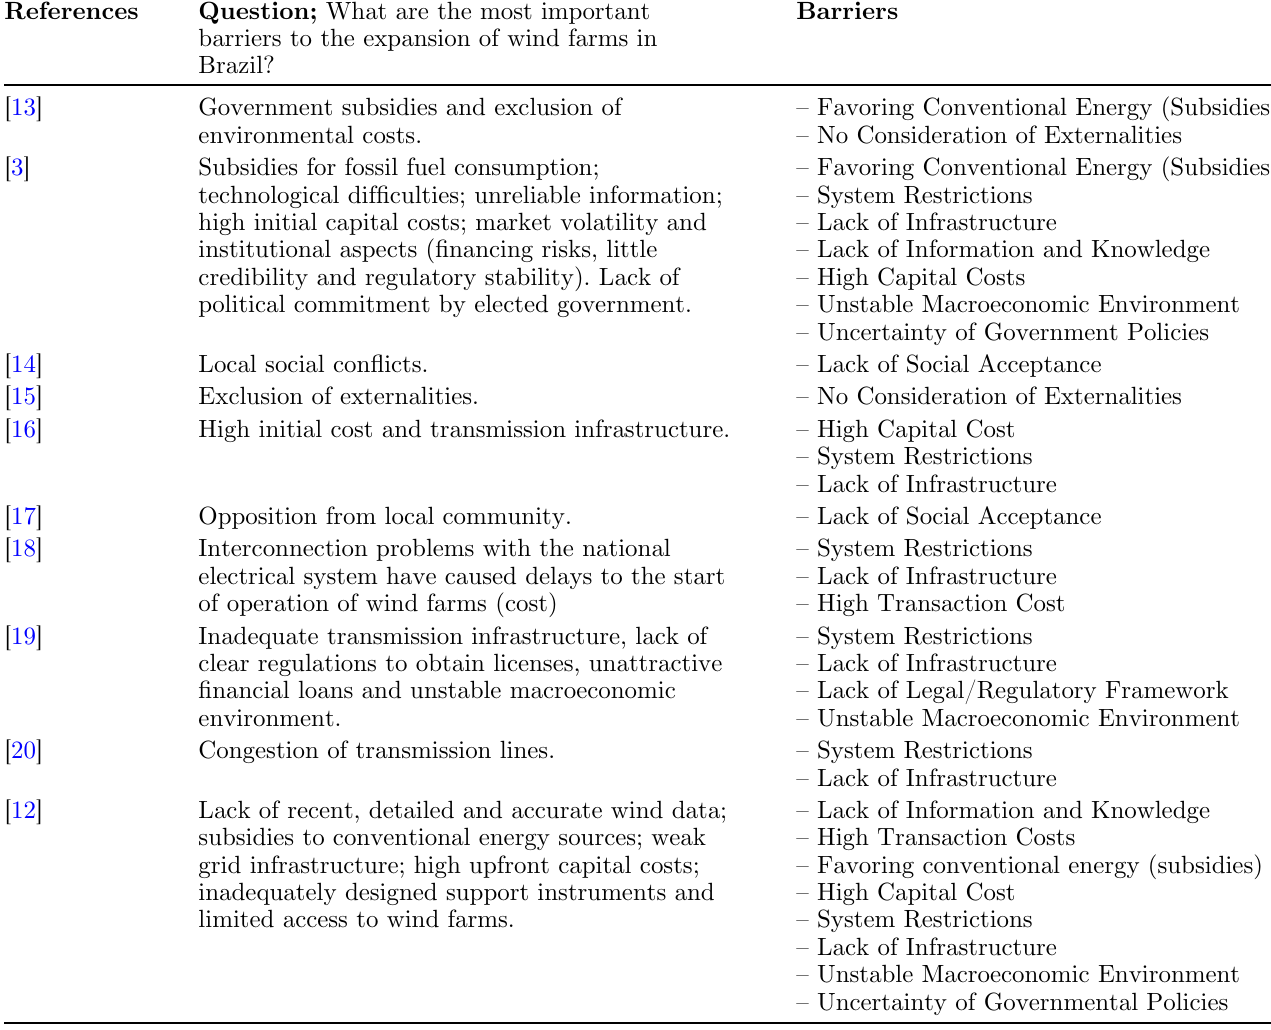
Table 4. Summary of the systematic literature review